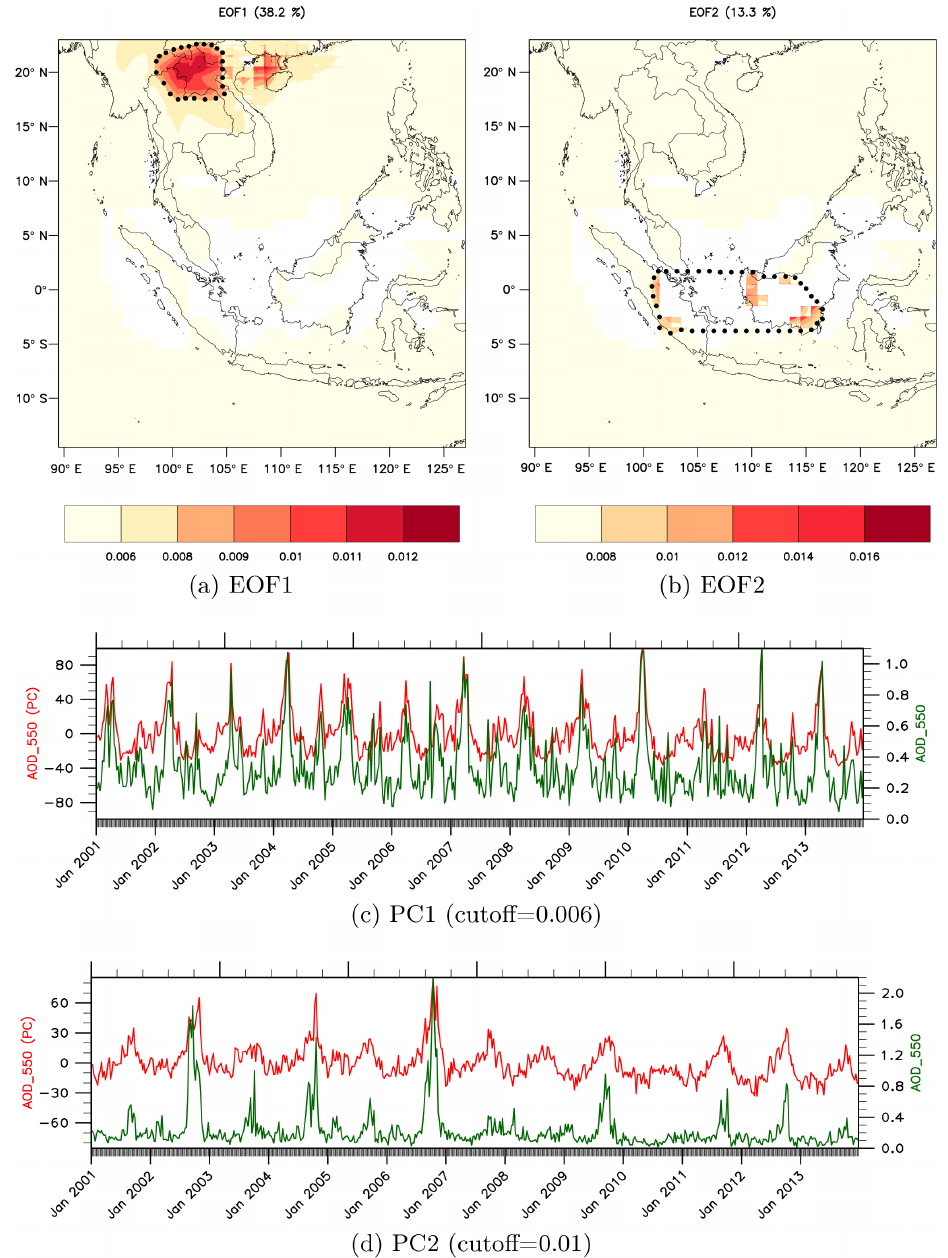
Figure 2. First line: EOF1 (38.2% of variance) (a) and EOF2 (13.3% of variance) (b) of the AOD (2001–2013). Regions of highest AOD variability are delineated by black dots. Second line: PC 1 (cutoff 0.006, PC on the left-hand axis, AOD on the right-hand axis) (c) (red curve) and their associated AOD (green curve) averaged on the region. Third line: PC 2 , (cutoff 0.01, PC on the left-hand axis, AOD on the right-hand axis) (d) (red curve) and their associated AOD (green curve) averaged on the